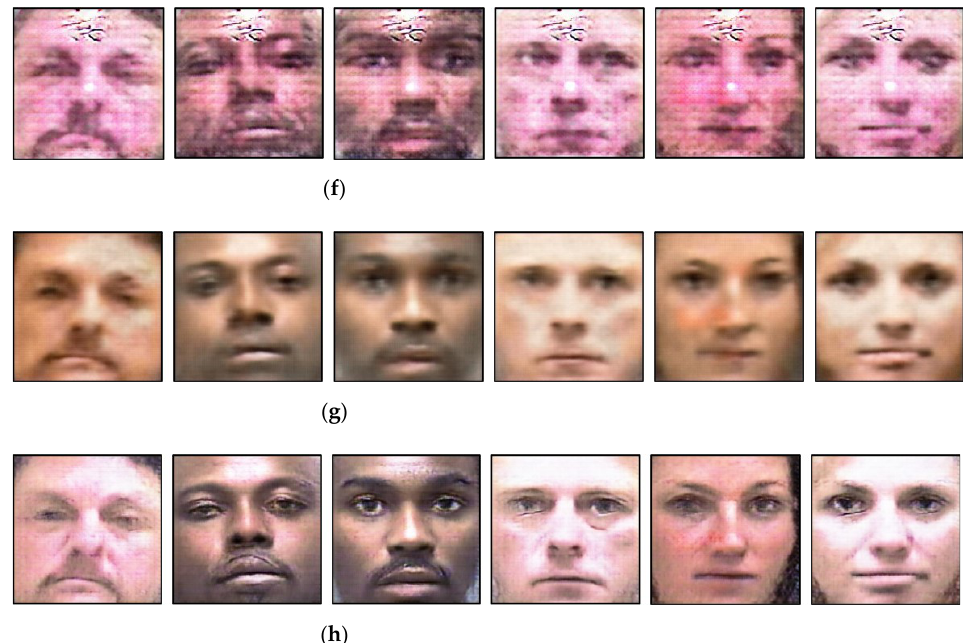
Figure 8. Examples of ( a ) original images, ( b ) low-illuminated images, ( c ) histogram equalized im- ages, and enhanced images by ( d ) CycleGAN, ( e ) Attention GAN, ( f ) Attention cGAN, ( g ) conditional GAN, and ( h ) LAE-GAN.